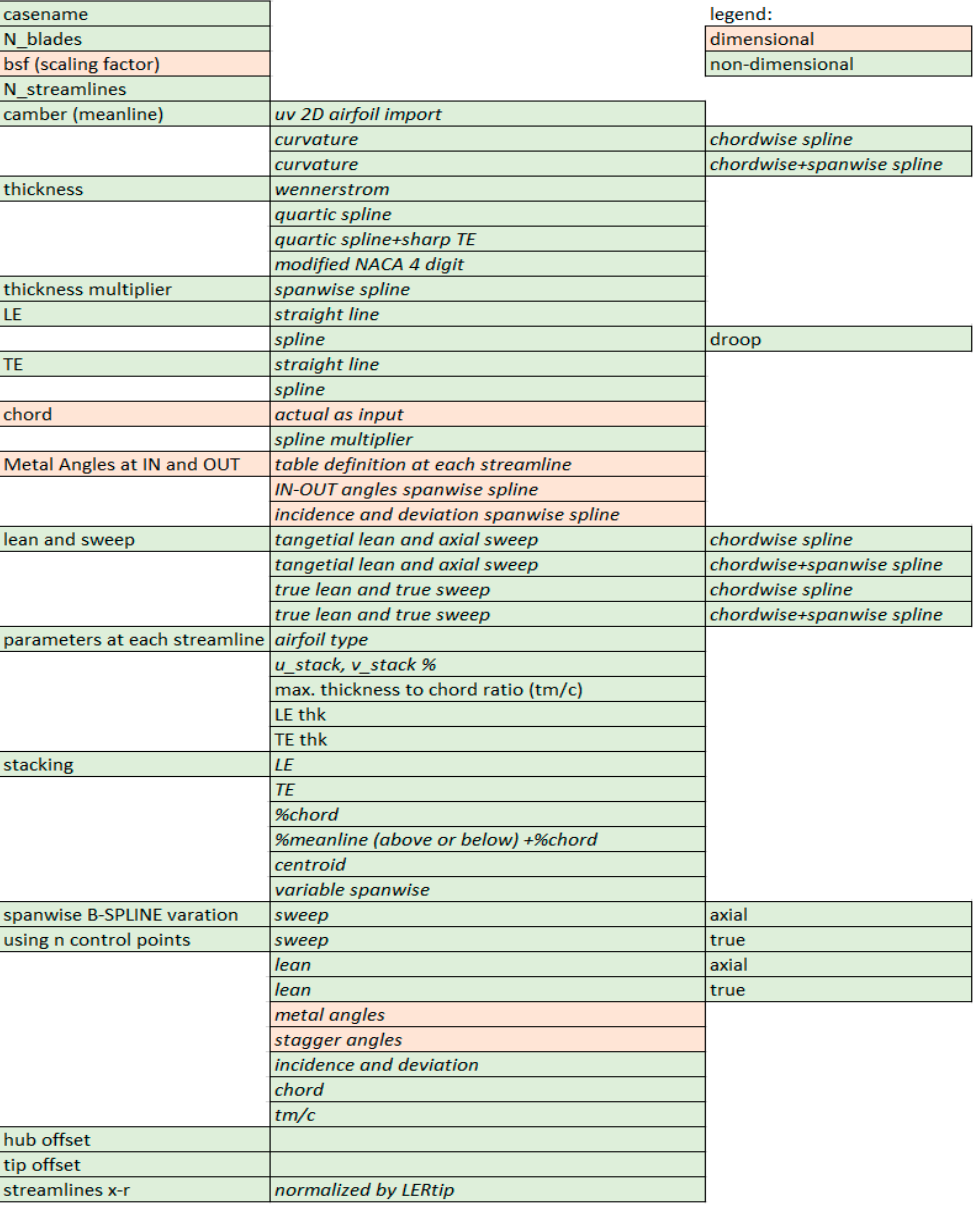
Figure 8. Non ‐ dimensional and dimensional parameters for geometry generation. Figure 8. Non-dimensional and dimensional parameters for geometry